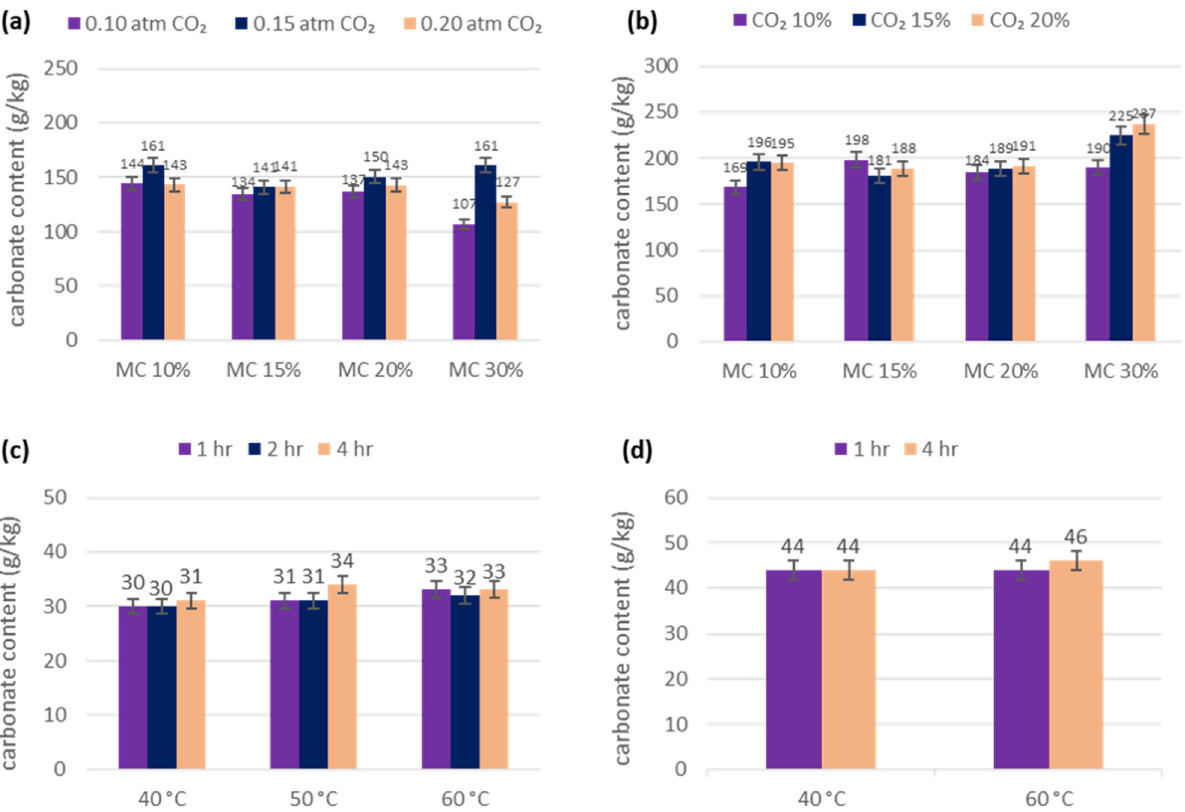
Figure 6. Carbonate content of incubator carbonated (144 h) wollastonite at ( a ) 35 ◦ C and ( b ) 50 ◦ C (calcimeter mean accuracy: ± 4.2%) and slurry carbonated wollastonite in ( c ) ultrapure water and ( d ) NaOH (calcimeter mean accuracy: ± 4.7%). Carbonate content of unreacted wollastonite is 41.7 g/kg.